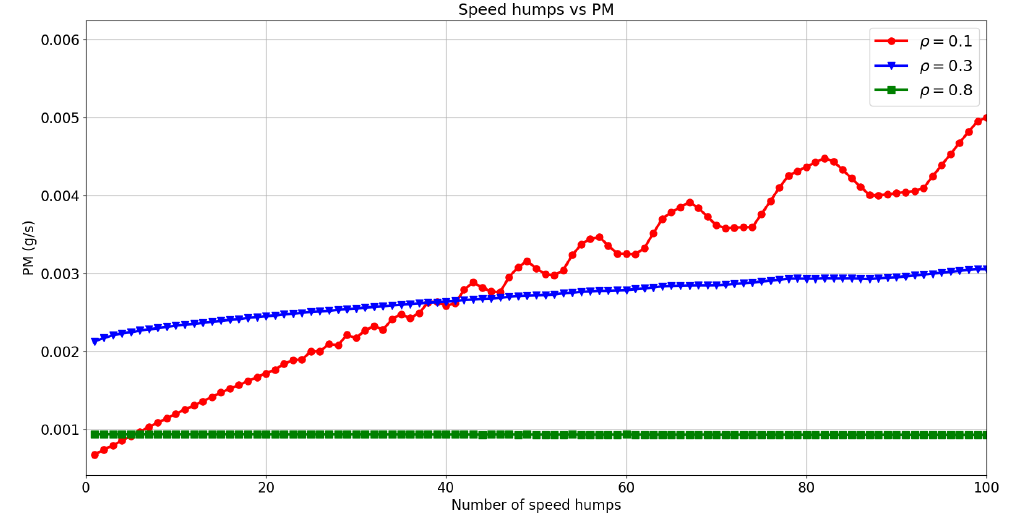
Figure 14. PM instant emissions as a function of the number of speed